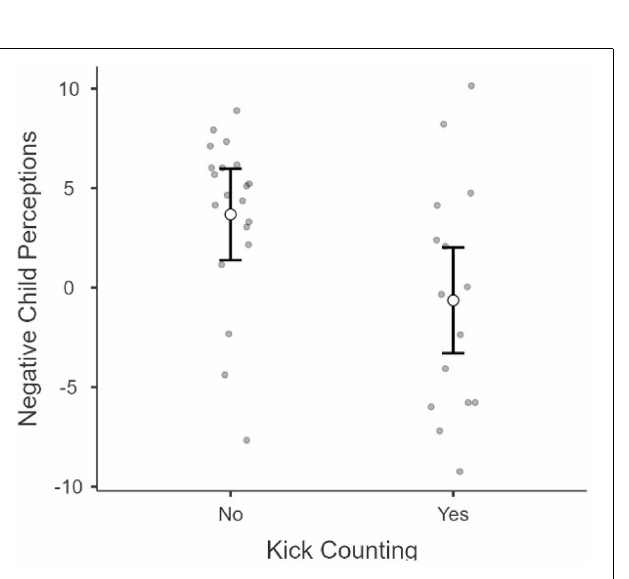
FIGURE 3 | Differences in Parent Negative Perceptions by Fetal Kick Counting Exposure. This figure demonstrates the significant impact seen in the K+ group postnatally as mothers who participated in the brief FKC intervention exhibited a decline in negative perceptions and attitudes toward their infants (EMQ-X) in comparison to the K − group.